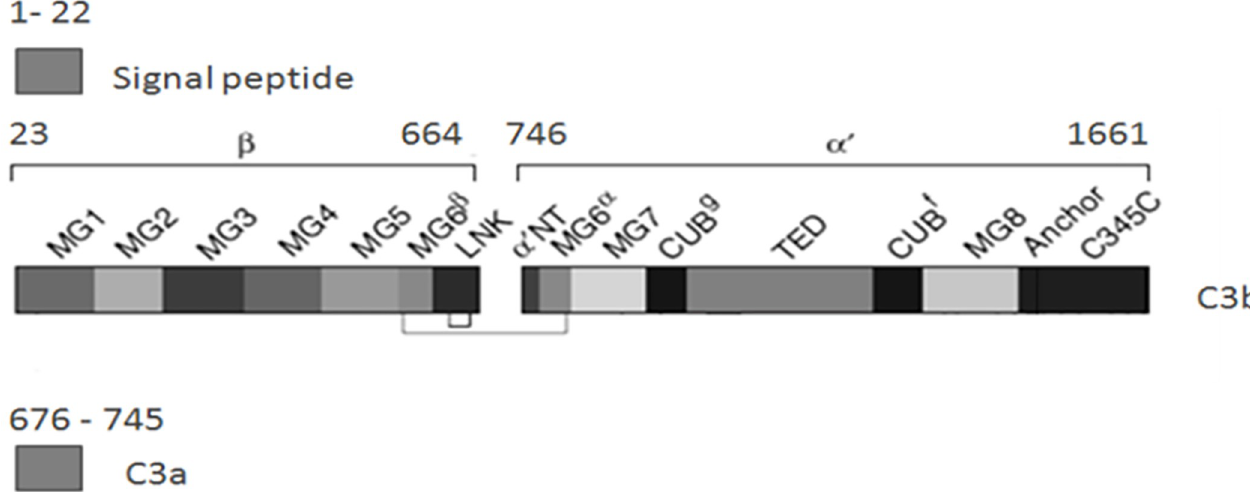
Fig 1. Shows the protein fragment of C3: The signal peptide and the alpha and beta chains, which consist of the C3a and C3b